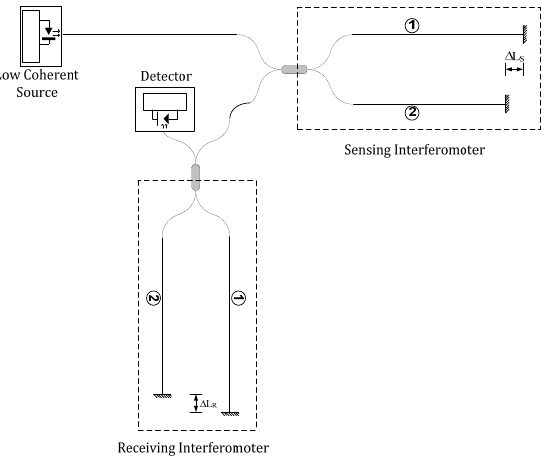
Figure 6. Basic low coherence interferometry system using Michelson interferometers. The optical path difference of the sensing interferometer, ∆ L S , is larger than the coherence length of the source. The light reflected back from the mirrors is passed down the directional coupler but does not interfere. This light is connected to a second interferometer, the reference interferometer. The optical path difference, ∆ L R , of this interferometer is made comparable to that of the sensing interferometer and necessarily within the coherence length of the source. Generally, in one of interferometers there is an open-air path, which is adjusted to match the optical path difference of the sensing interferometer, with the consequence that part of the radiation is brought back into temporal coherence by the interaction of the two interferometers, resulting in an interference signal that is detected on the output